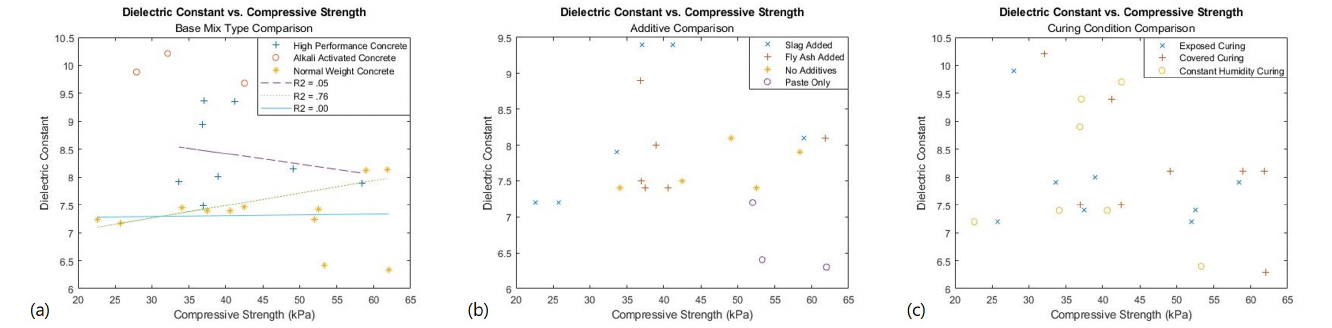
Figure 7. Dielectric constant vs. compressive strength (kPa) with breakdowns of base mix ( a ), additives ( b ), and curing condition ( c